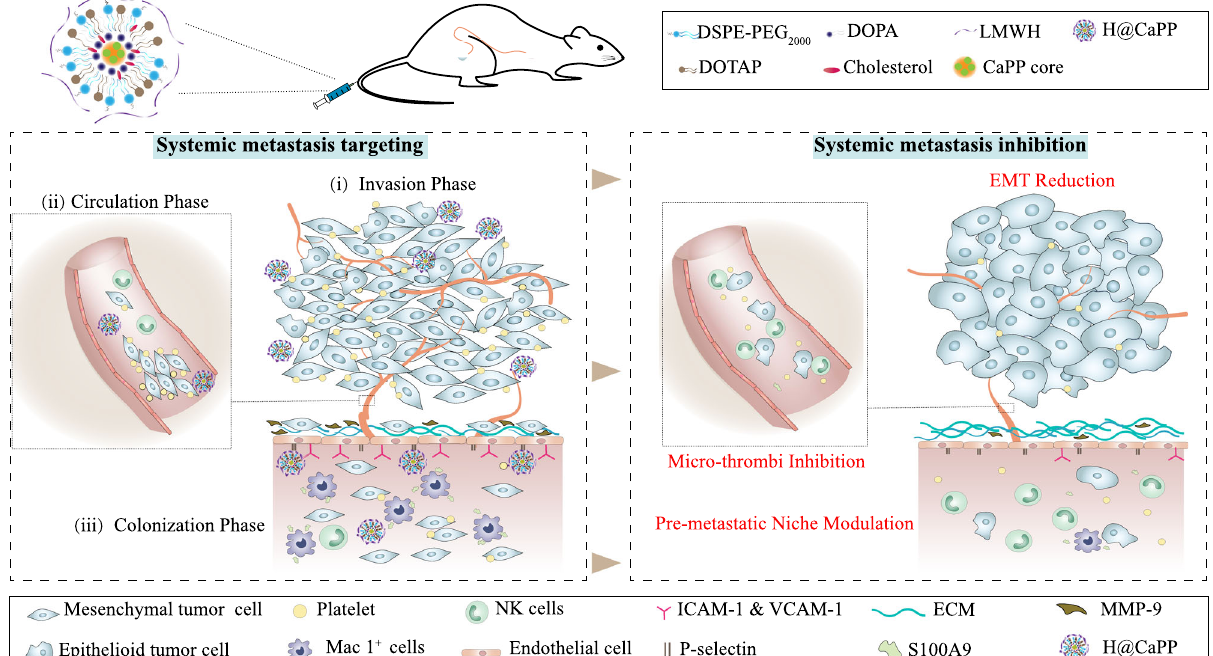
Fig. 1 Schematic illustration of the composition and anti-metastasis function of H@CaPP. H@CaPP was intravenously administered to suppress the whole metastasis process. H@CaPP hindered invasion phase via inhibition EMT process in the primary tumor, hindered colonization phase via inhibiting the formation of “ micro-thrombi ” in the circulation, and hindered the colonization phase via targeting P-selectin in the pre-metastatic niche and inhibiting typical aberrant alterations in the